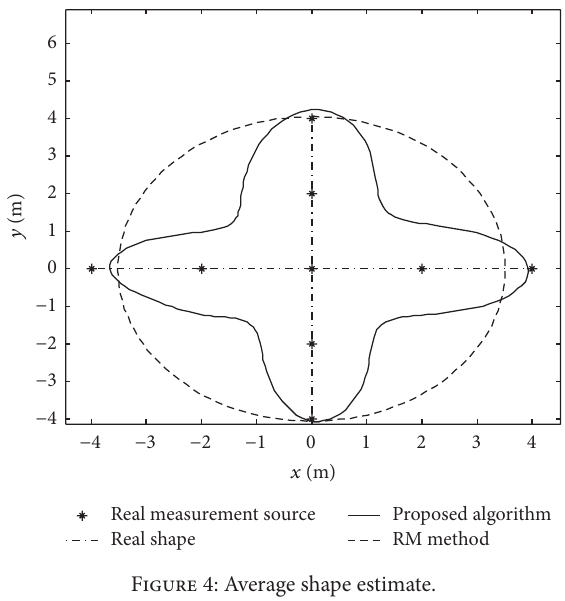
Figure 4: Average shape estimate.